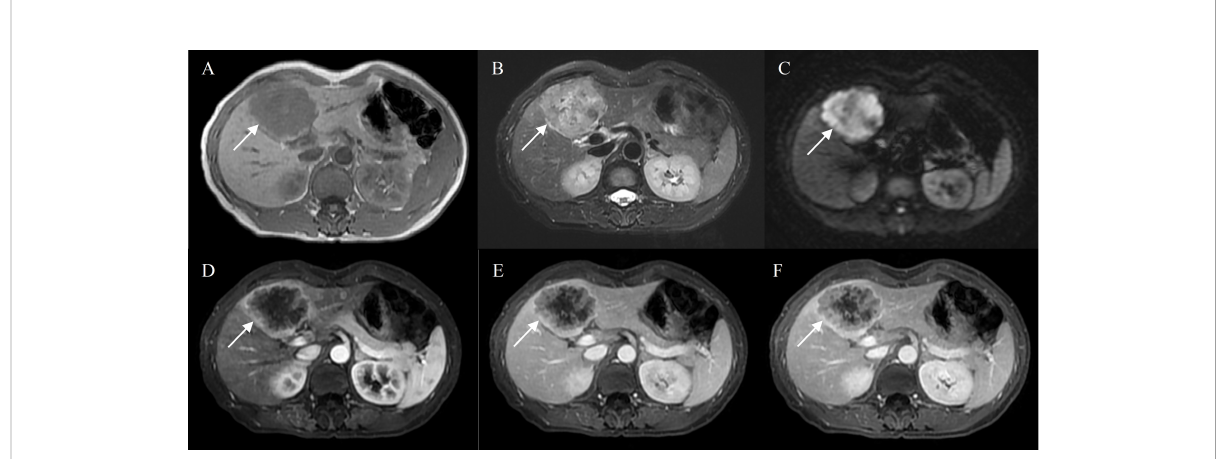
FIGURE 4 Intrahepatic mass-forming cholangiocarcinoma in a 50-year-old female with hepatitis B virus. Gd-DTPA-enhanced MRI detected a lobulated tumor (7.0 cm) with heterogeneous SI on T1WI and T2WI (A, B) , restricted diffusion (C) . Peripheral rim-like enhancement in the arterial phase